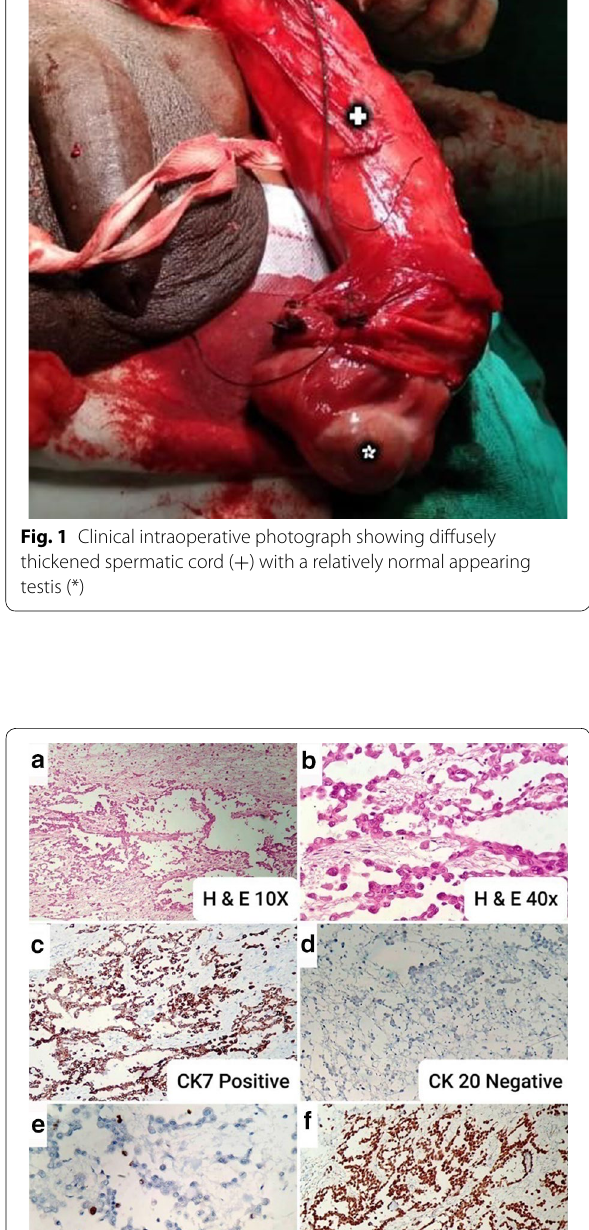
Fig. 2 Panel images a , b showing H&E staining revealing stromal invasive neoplasm with papillary and glandular configuration (10 ) with cuboidal lining cells with scant to moderate amount of × eosinophilic cytoplasm and bland nuclear features (40 (section c – f ) showed Cytokeratin 7 and Calretinin positivity